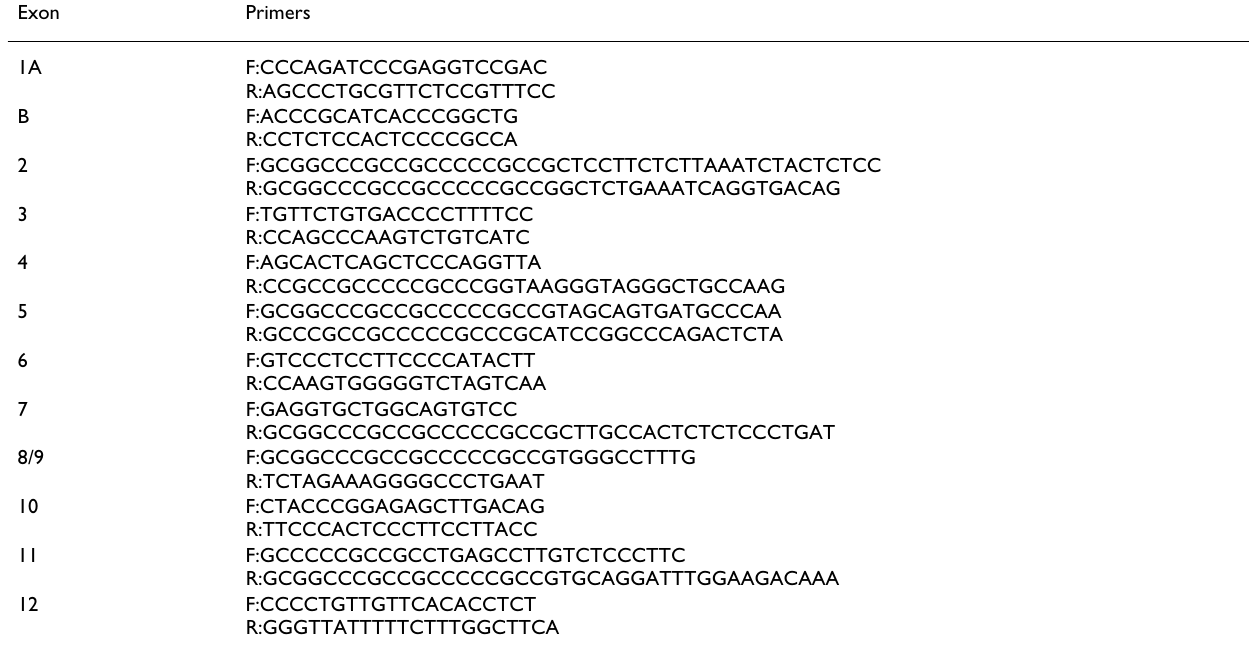
Table 1: Primers for amplifying LMNA for DHPLC and SSCP analysis. All sequences are listed 5' to